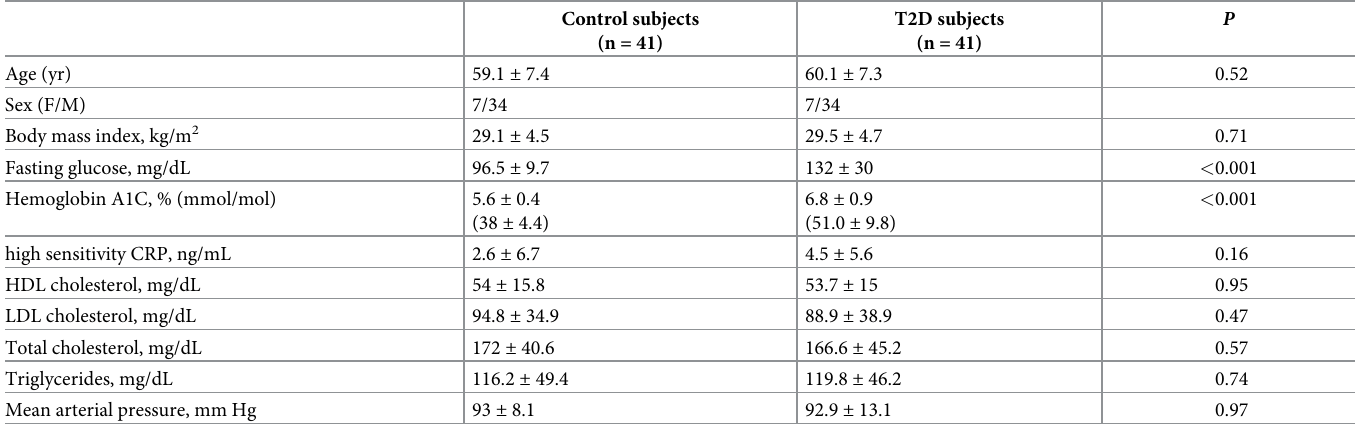
Table 1. Clinical characteristics of the study